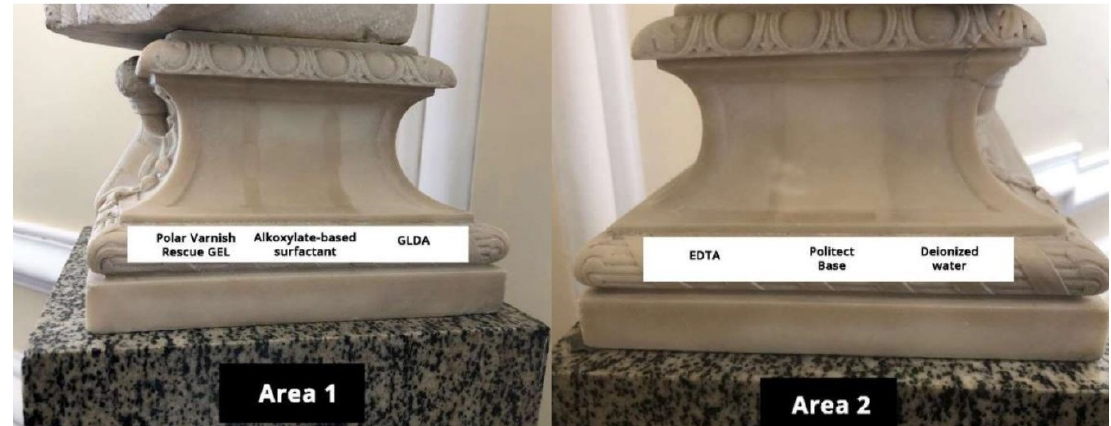
Figure 8. Photographs of the surfaces after treatment.